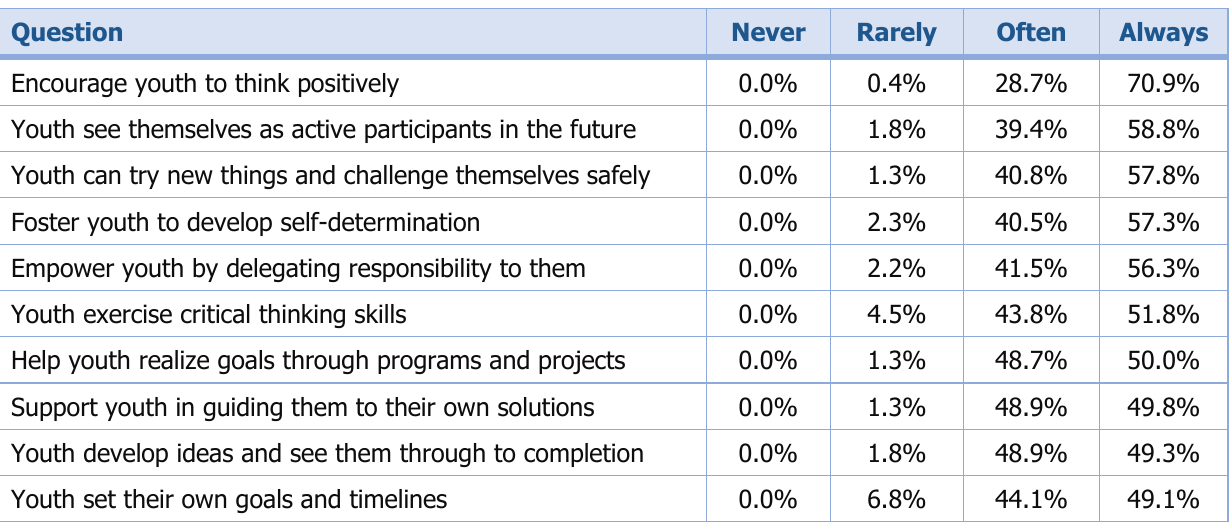
Table 4. Frequency of Volunteer Responses to Questions on Practices That Promote Independence